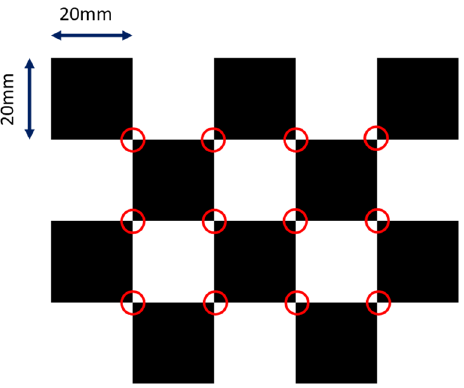
Figure 2. The layout of the checkerboard. The detectable image feature points are marked in red circles.